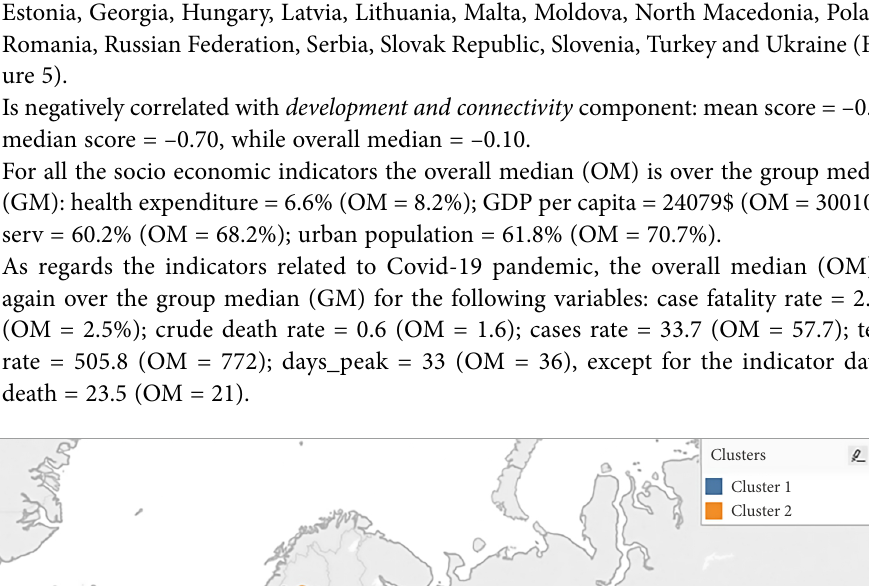
Cluster 1 Cluster